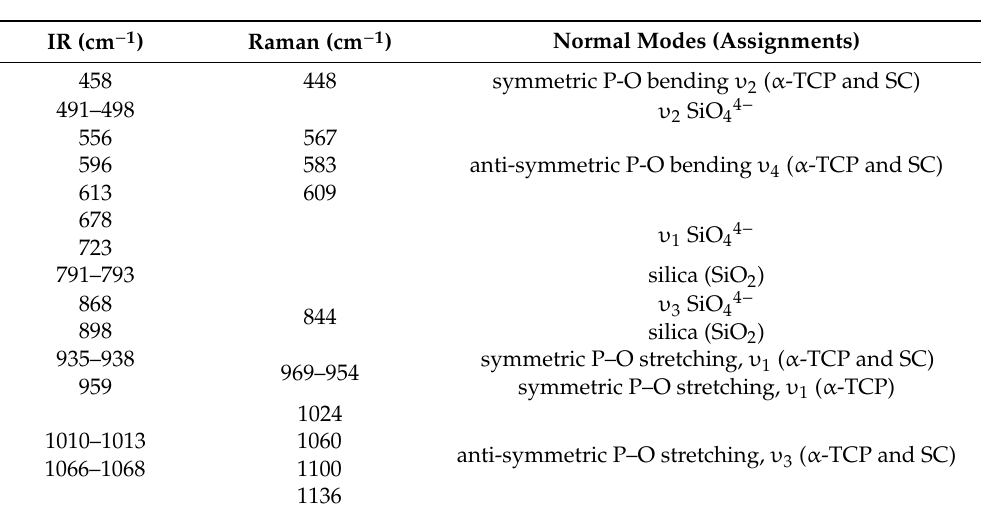
Figure 3. FTIR ( A ) and Raman ( B ) studies. Table2. MainbandsandtheircharacteristicwavenumbersinFT-IRandRamanspectroscopy( α -TCPand SC